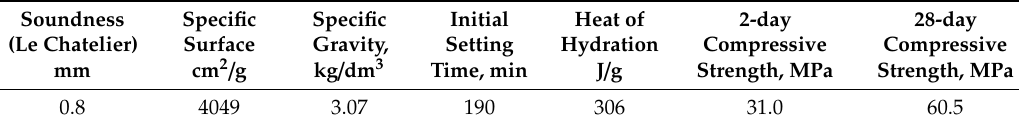
Table 3. CEM I 42.5 R cement and its physical properties.